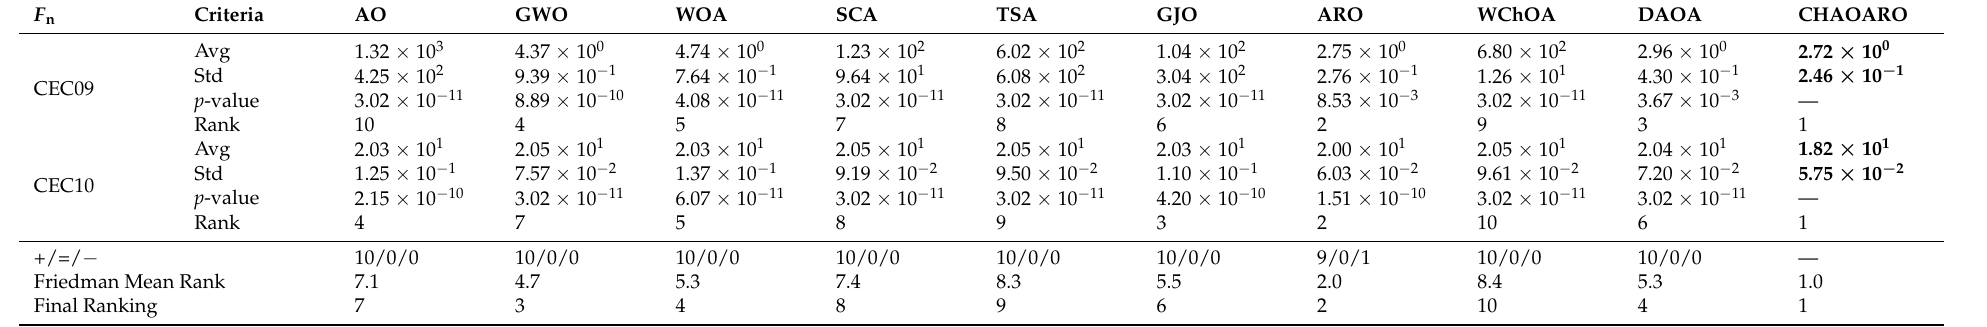
The best values obtained have been highlighted in boldface